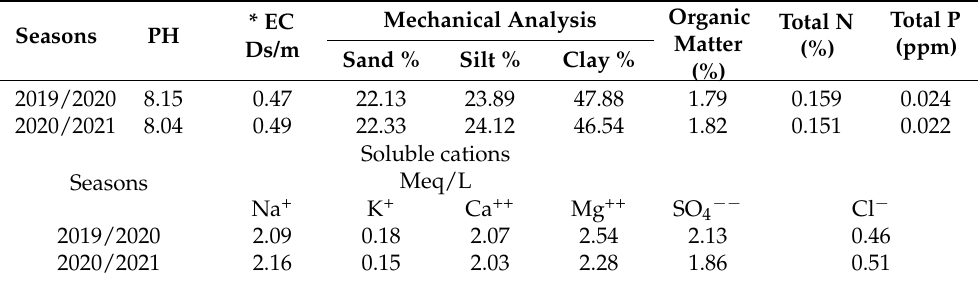
Table 1. Chemical characters of the experimental soil during two growing seasons before conducting the